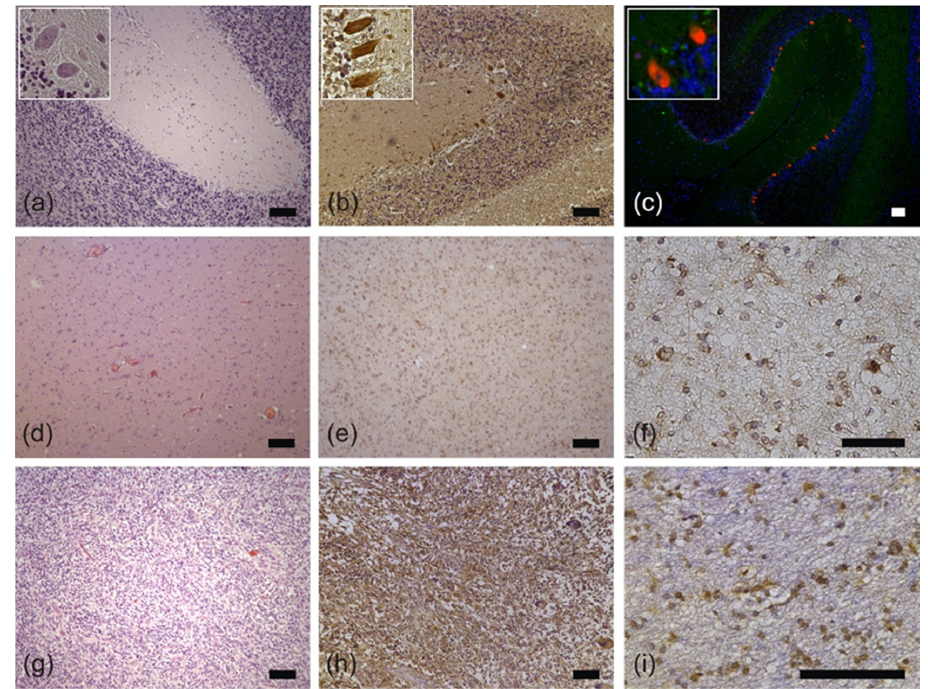
Figure 1. Representative examples of RPS27 immunohistochemistry. ( a ) H&E, ( b ) RPS27-DAB, and ( c ) RPS27 fluorescence staining of normal cerebellar tissue. Purkinje cells were positive for RPS27 staining (red). DAPI = blue. Insets’ objective magnification 40×. ( d ) H&E, ( e ) and ( f ) RPS27-DAB staining of an exemplary WHO grade II glioma. ( g ) H&E, ( h ) and ( i ) RPS27-DAB staining of an exemplary glioblastoma. Scale bars = 100 µm.